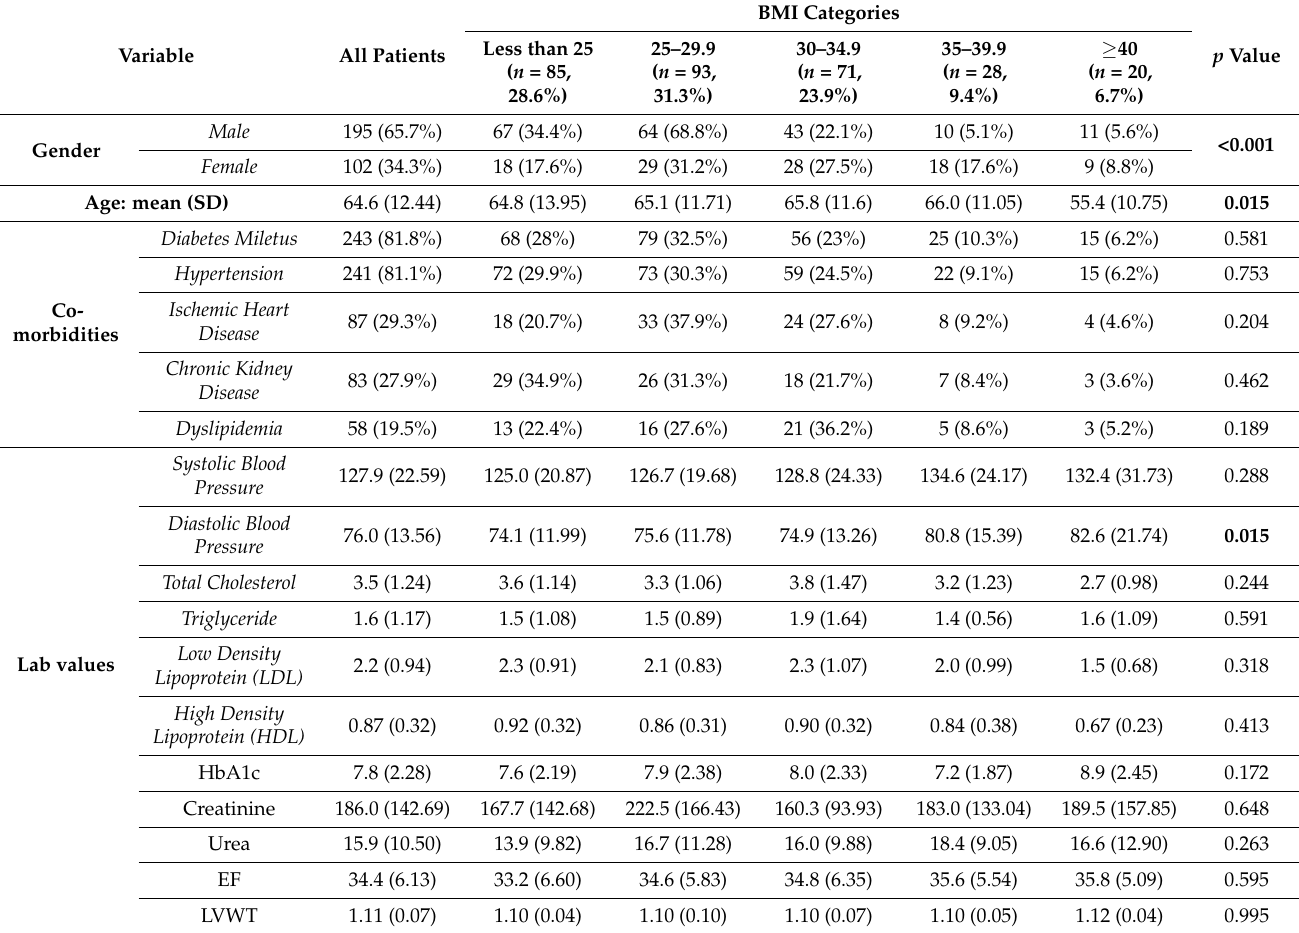
Table 1. Baseline demographics, co-morbidities and biochemical